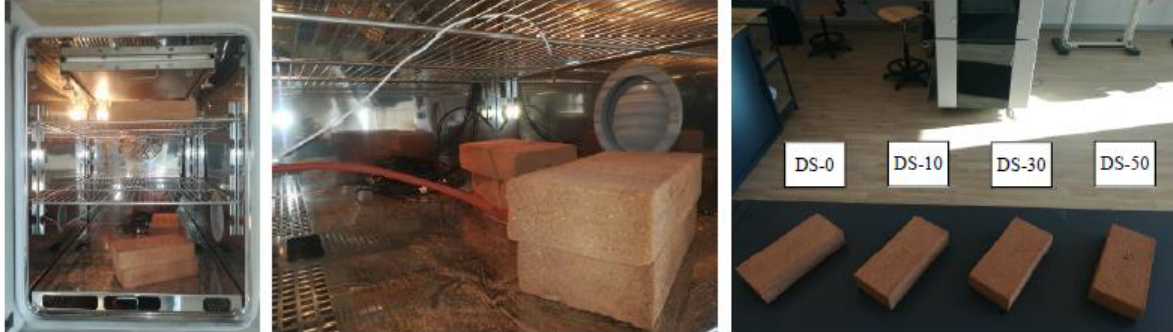
Figure 2. From the left, the climatic chamber apparatus, a detailed view of the hot disk measuring sensor, and an overview of the four brick specimens that were assessed.